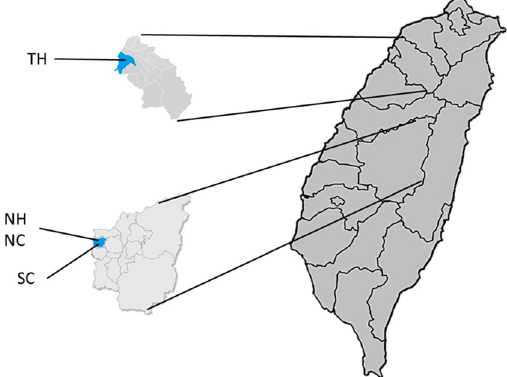
Figure 1. Sample collection map. Samples were collected from acute care hospitals (TH and NH) and long- term care facilities (NC and SC). NH and NC are located in the same building. Chen CH and Chen KH generate three maps using Ulead Photoimpact software version 12.0 (http://www.paintshoppro.com/tw/products/